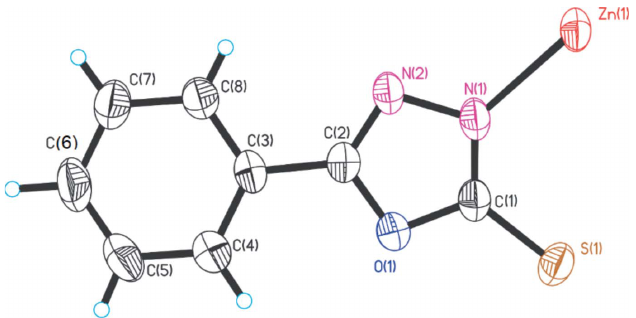
Figure 1 The molecular structure of [Zn 0.5 L ] with the atom-numbering scheme. Displacement ellipsoids are drawn at the 50% probability level and H atoms are displayed as small spheres of arbitrary